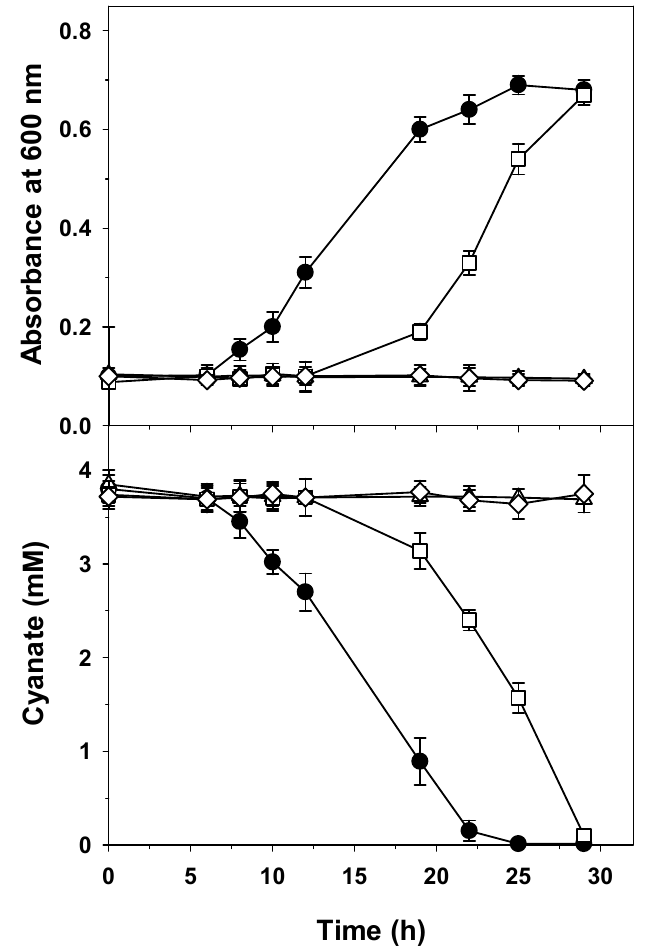
Figure 2. Growth and cyanate consumption of the wild-type strain ( (cid:8) ) and the CynF − ( (cid:52) ), CynBD − ( (cid:3) ), and CynS − ( ) mutants of P. pseudoalcaligenes CECT5344 in media with cyanate. Cells were grown in the minimal medium M9 with 4 mM cyanate as the sole nitrogen source, and at the indicated times, the bacterial growth (A 600 ) and cyanate concentration in the media were determined. Error bars show standard deviations of three independent replicates.